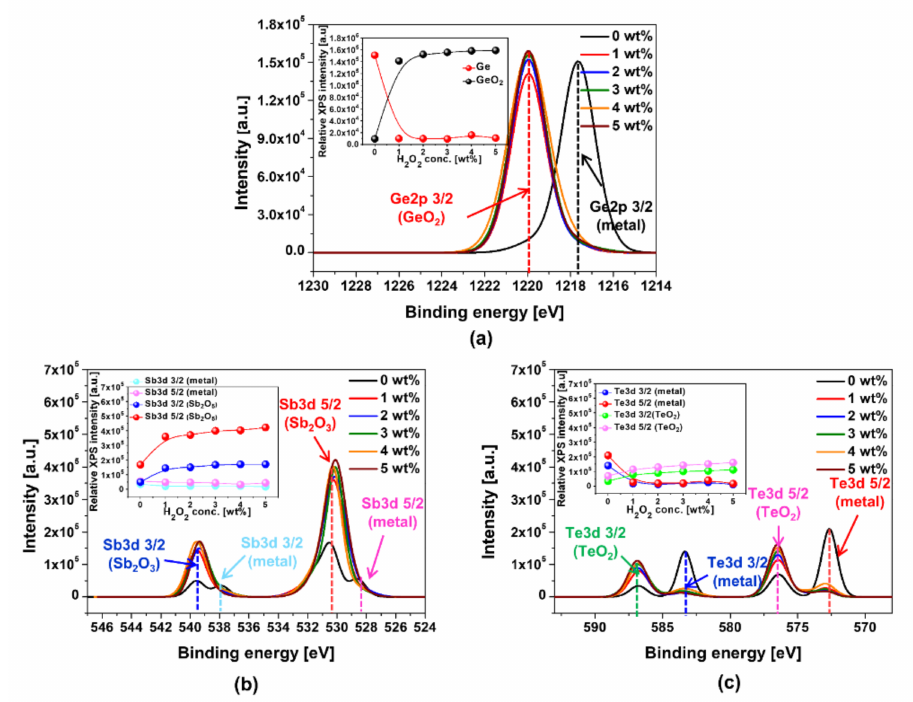
Figure 1. Dependency of chemical composition of Ge 1 Sb 4 Te 5 film surface on oxidant (i.e., H 2 O 2 ) concentration. ( a ) Ge 2p spectra, ( b ) Sb 3d spectra, and ( c ) Te 3d spectra.